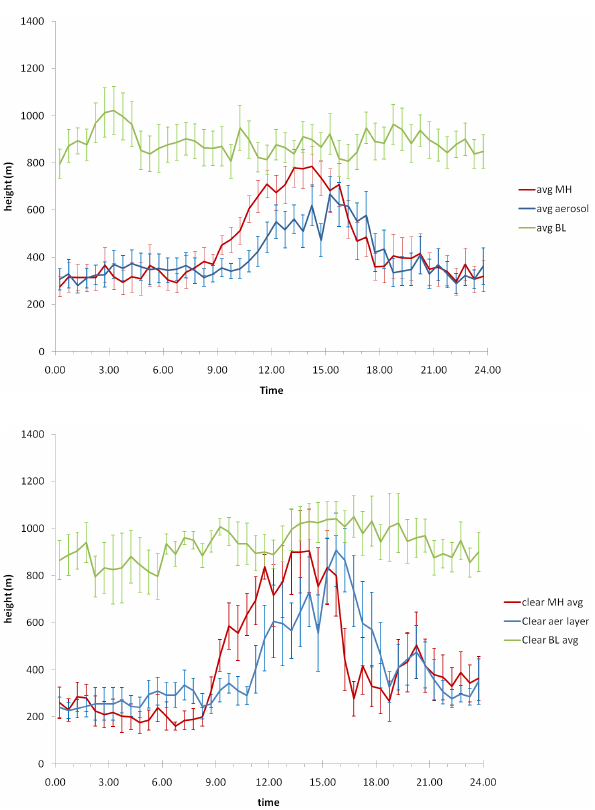
Fig. 5. Averages of derived boundary layer top (BL), aerosol layer Figure 5. Averages of derived boundary layer top (BL), aerosol layer (aerosol) and mixing (aerosol) and mixing height (MH) for diurnal cycle during REPAR- height (MH) for diurnal cycle during REPARTEE II. Error bars show standard error. b) clear TEE II. Error bars show standard error. (a) all periods, (b) clear sky sky periods only. periods